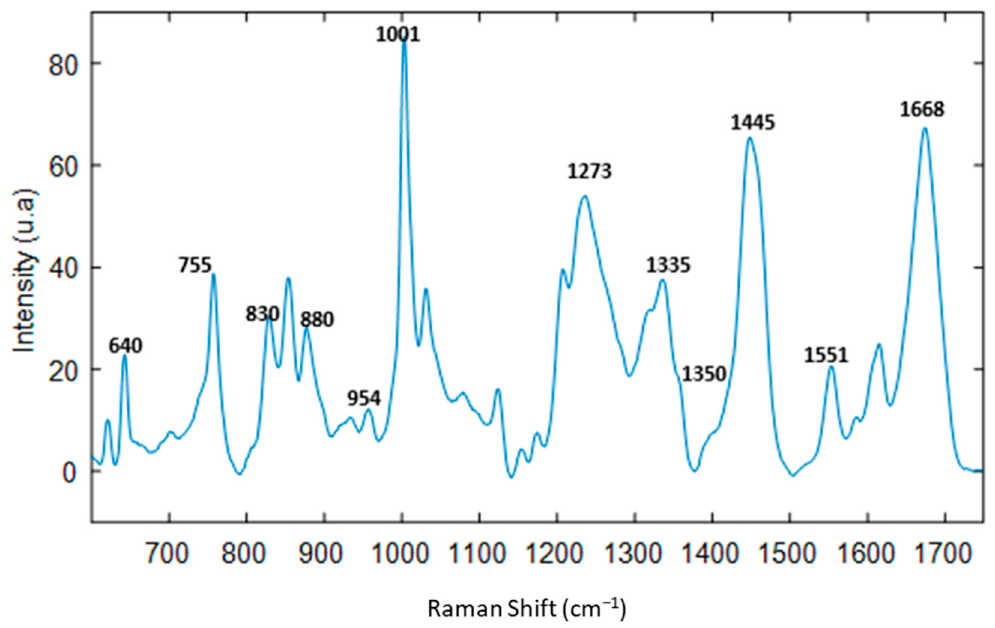
Figure 5. Mean Raman spectrum of 16 mAbs after filtration of the excipients, acquired by depositing drops after 45 min of drying.